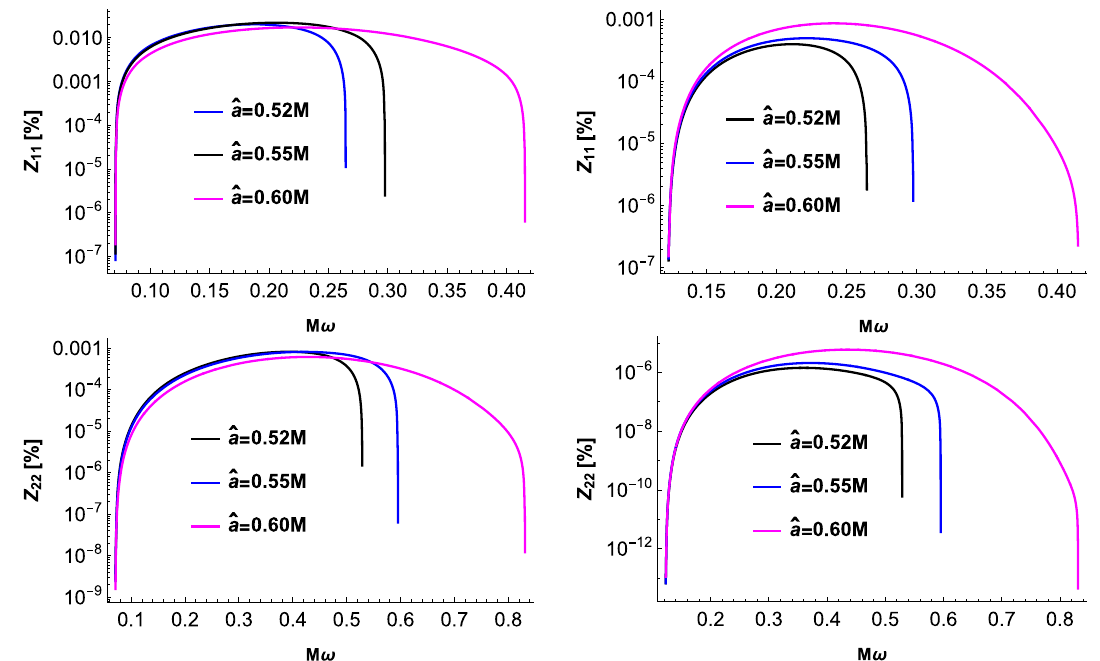
Fig. 7 Variation of amplification factors with ˆ a for various multipoles with ˆ μ = 0 . 1 and b = 0 . 02 M 2 . For left ones (cid:2) = − 0 . 5 and for right ones (cid:2) = 0 . 5